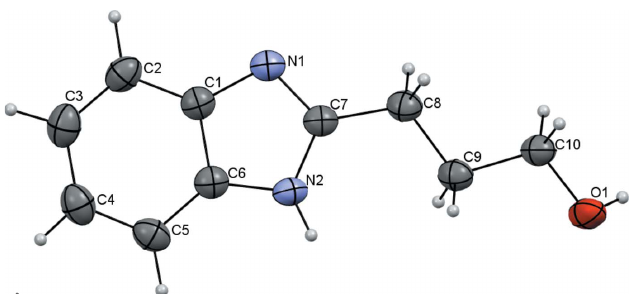
Figure 1 Molecular structure of the neutral 2-(3-hydroxypropyl)benzimidazole molecule in the BIZ structure. Displacement ellipsoids are shown at the 50% probability level.